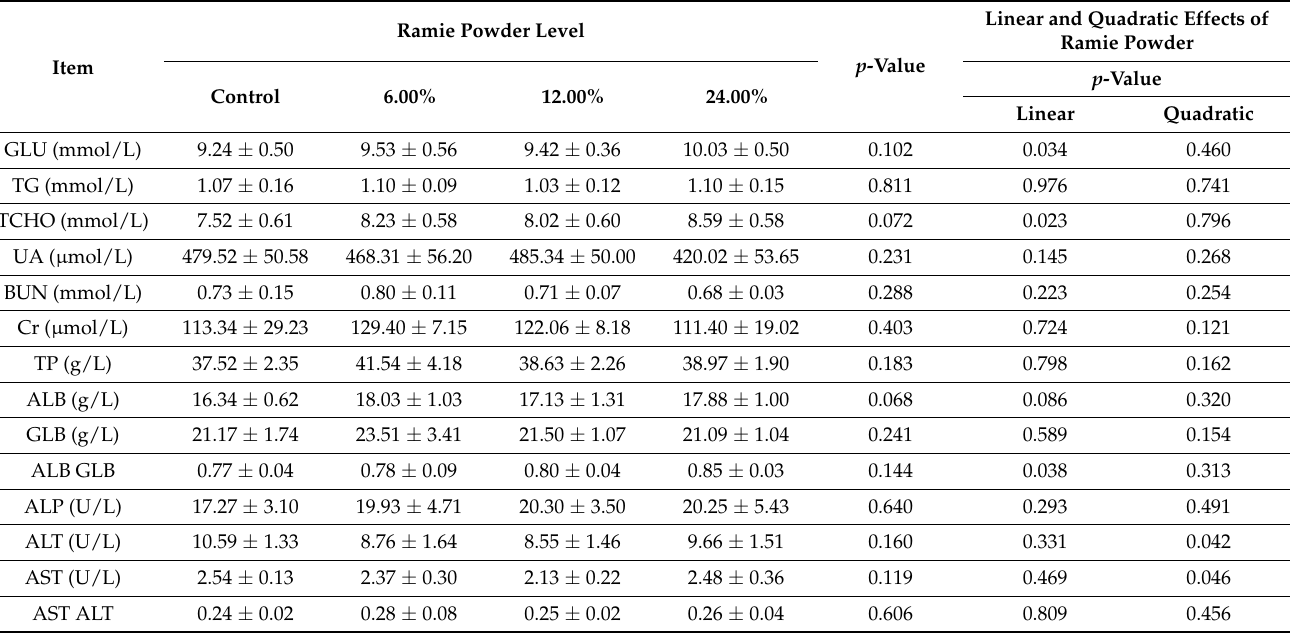
Table 6. Effect of the different ramie powder levels in the diets on the serum biochemical indices of 98 day old Yanling white